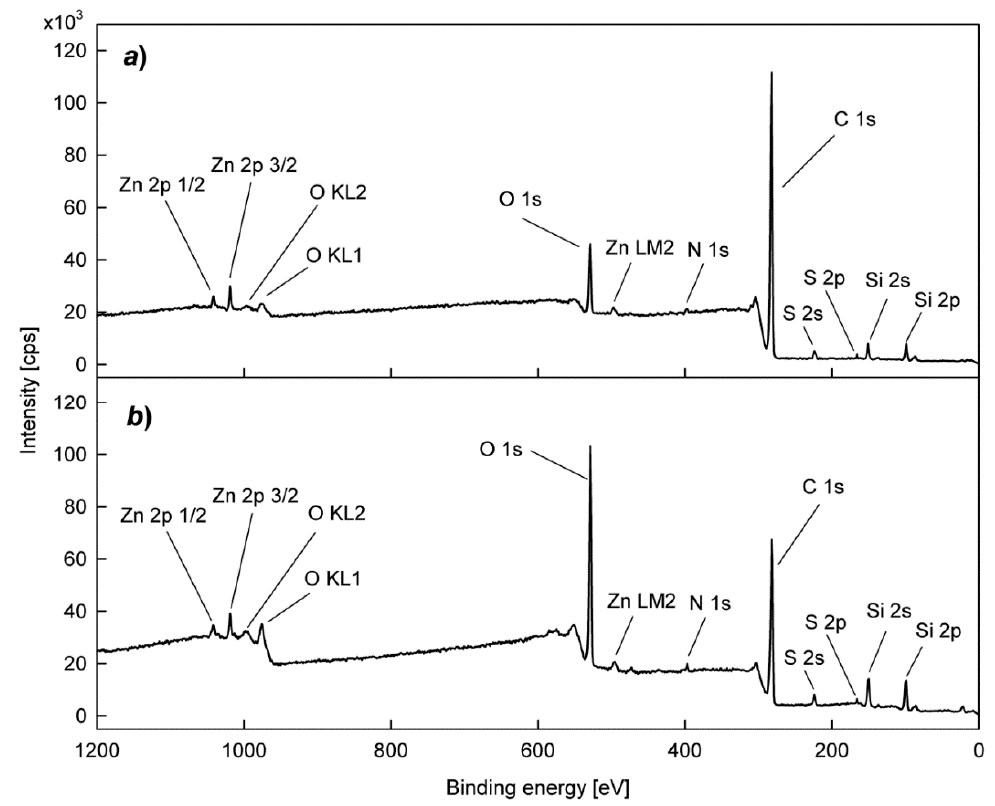
Figure 4. XPS wide scan spectra for SBS rubber with 50 phr of carbon black: ( a ) before plasma treatment; Figure 4 . XPS wide scan spectra for SBS rubber with 50 phr of carbon black: a ) before plasma ( b ) after plasma treatment (O 2 plasma, 80 W). Polymers 2020 , 12 , x FOR PEER REVIEW treatment; b ) after plasma treatment (O 2 plasma, 80 W).